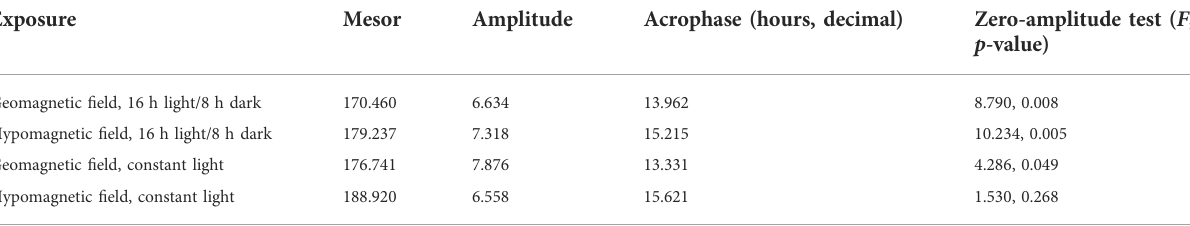
TABLE 2 Cosinor analysis results of the zebra fi sh heart rate at different magnetic and light conditions (24 h rhythm for 72 – 116 hpf). Exposure Mesor